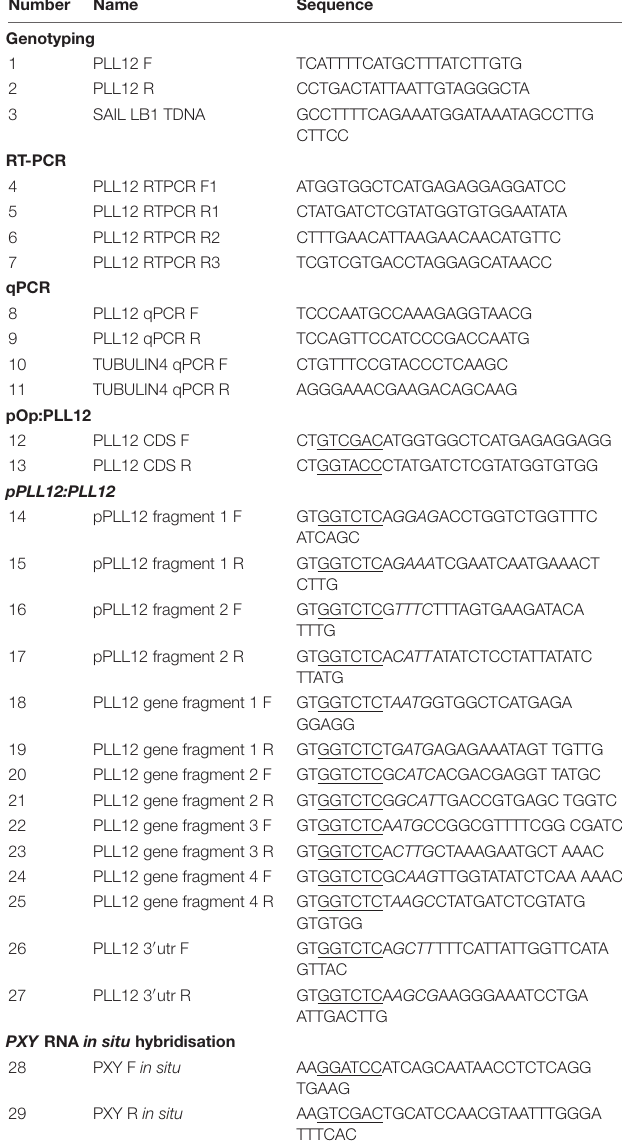
TABLE 1 | Oligonucleotide